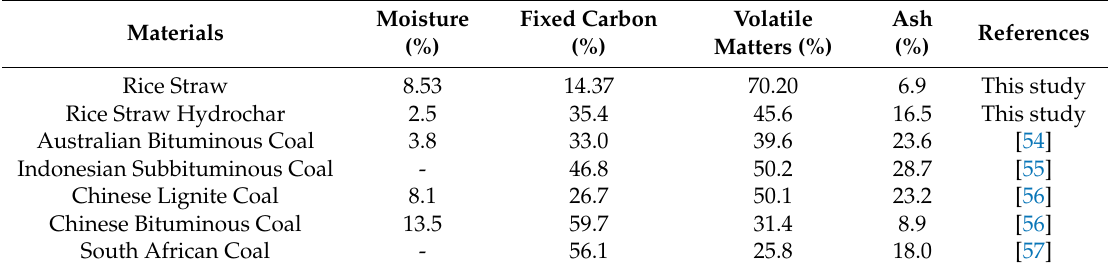
Table 5. The proximate analysis of rice straw, the optimized hydrochar and different types of coals.